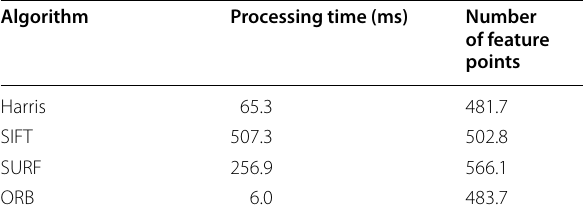
Table 1 Comparison of the performance of different algorithms Algorithm